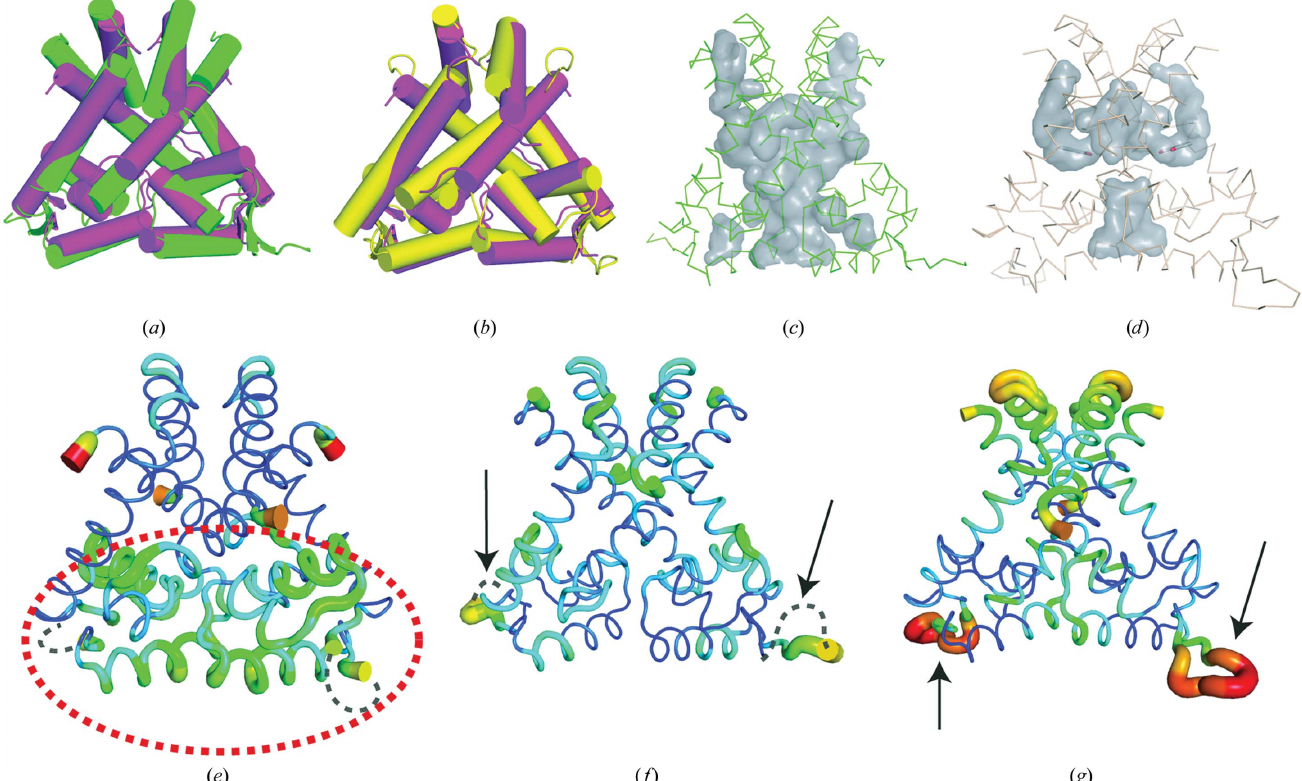
Figure 4 Structural comparison of Pa MarR with temperature-dependent homologues. ( a ) Overall structural comparison between Pa MarR and Bs MarR. The structure of Pa MarR (magenta) is superimposed onto that of Bs MarR (green). ( b ) Overall structural comparison between Pa MarR and St MarR. The structure of Pa MarR (magenta) is superimposed onto that of Bs MarR (yellow). ( c , d ) The cavities of Bs MarR ( c ) and St MarR ( d ). Grey lumps indicate cavities, including their effector-binding sites. The overall structures of Bs MarR and St MarR are shown as ribbons. Salicylate is represented as sticks. ( e )–( g ) B -factor distributions of Pa MarR ( e ), Bs MarR ( f ) and St MarR ( g ). The structures are shown in putty representation and are rainbow-coloured from red to violet in B -factor value order. The dashed ellipse indicates the DNA-binding domain in Pa MarR and the arrows indicate the loop regions between the (cid:2) 1 and (cid:2) 2 strands in Bs MarR and St MarR. The dashed curves shown in ( e ) and ( f ) indicate disordered